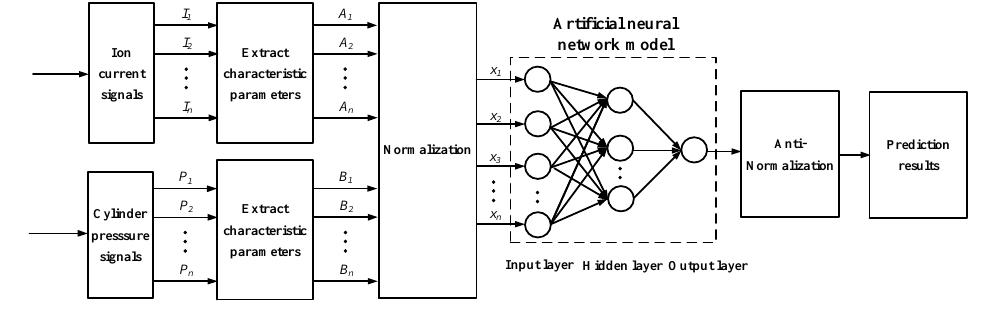
Figure 13. Schematic diagram of artificial neural network.